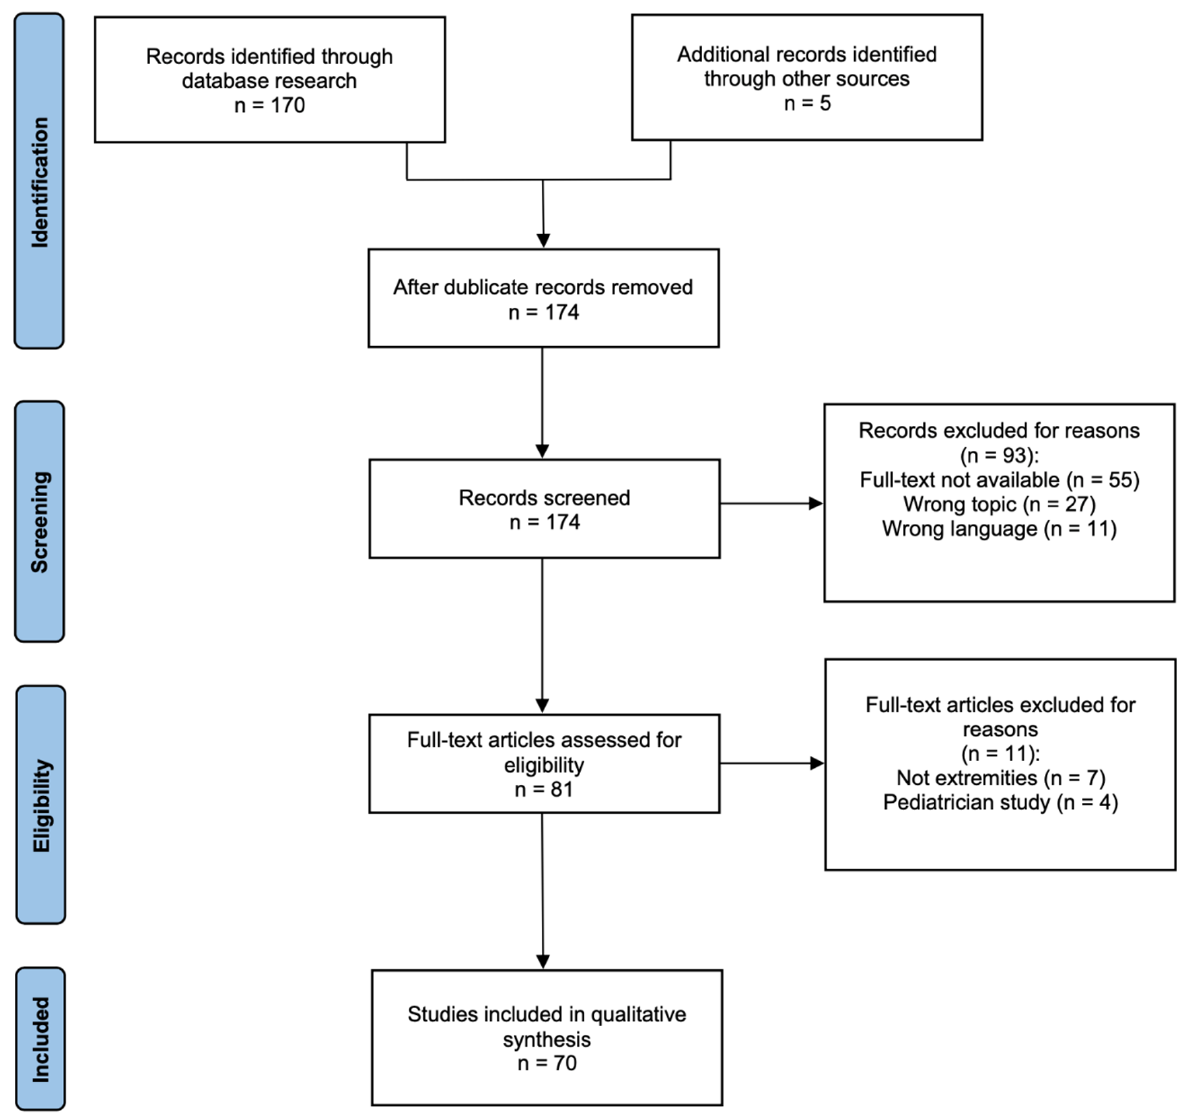
Figure 1. Flowchart of literature research and analysis.